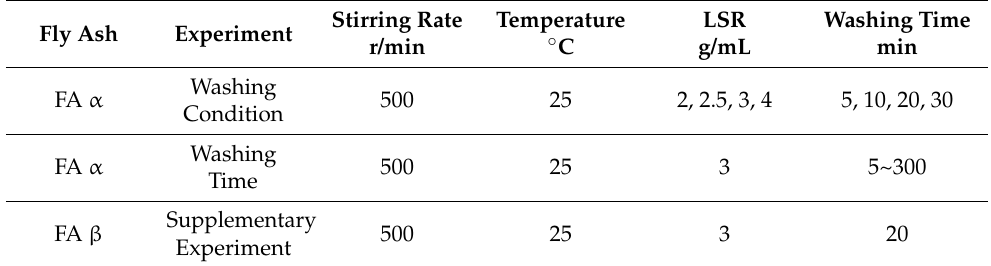
Table 2. Washing experiment condition.